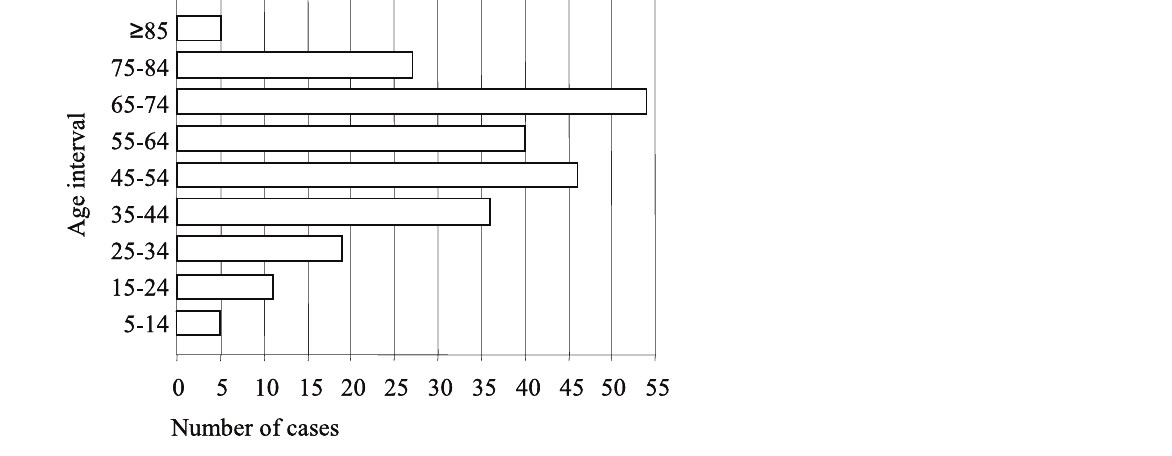
Figure 2. Age distribution of cystic echinococcosis human cases reported in Spain in 2006. Source: National Statistics Institute. Five autochthonous CE cases are found in the age range 5–14 years, indicating active transmission of the parasite. The rest of the cases are distributed as follows: 11 cases among 15- to 24-year-old patients, 19 among those aged 25–34, 36 among those aged 35–44, 46 among those aged 45–54, 40 among those aged 55–64, 54 among those aged 65–74, 27 among those aged 75–84, and five among patients aged 85 years old or more.